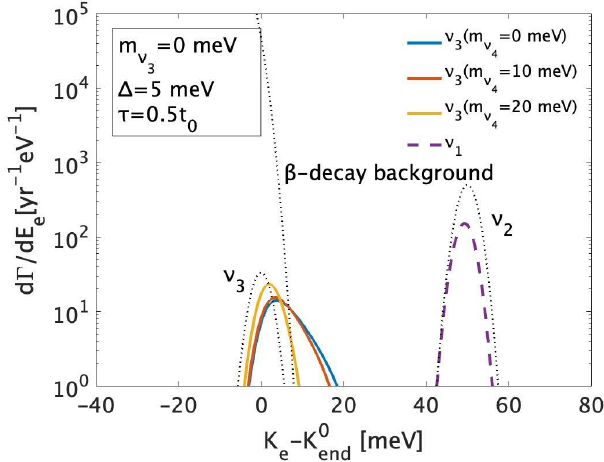
= 0 meV from the 3-body decays, ν Figure 6 . The expected spectra with m ν 3 neutrino capture on 100 g of tritium for the IO case. We set τ several values of m . Blue, red and yellow lines denote the spectra for ν ν 4 of ν for m = 0 , 10 , 20 meV , respectively. A purple dashed line denotes the spectrum for ν 1 ν 4 produced in the early universe but suppressed by the decays of ν contributions of the spectra for ν and ν produced in the early universe and β -decay 2 3